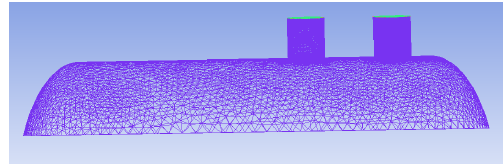
Figure 4. Simulation mesh of air chamber.